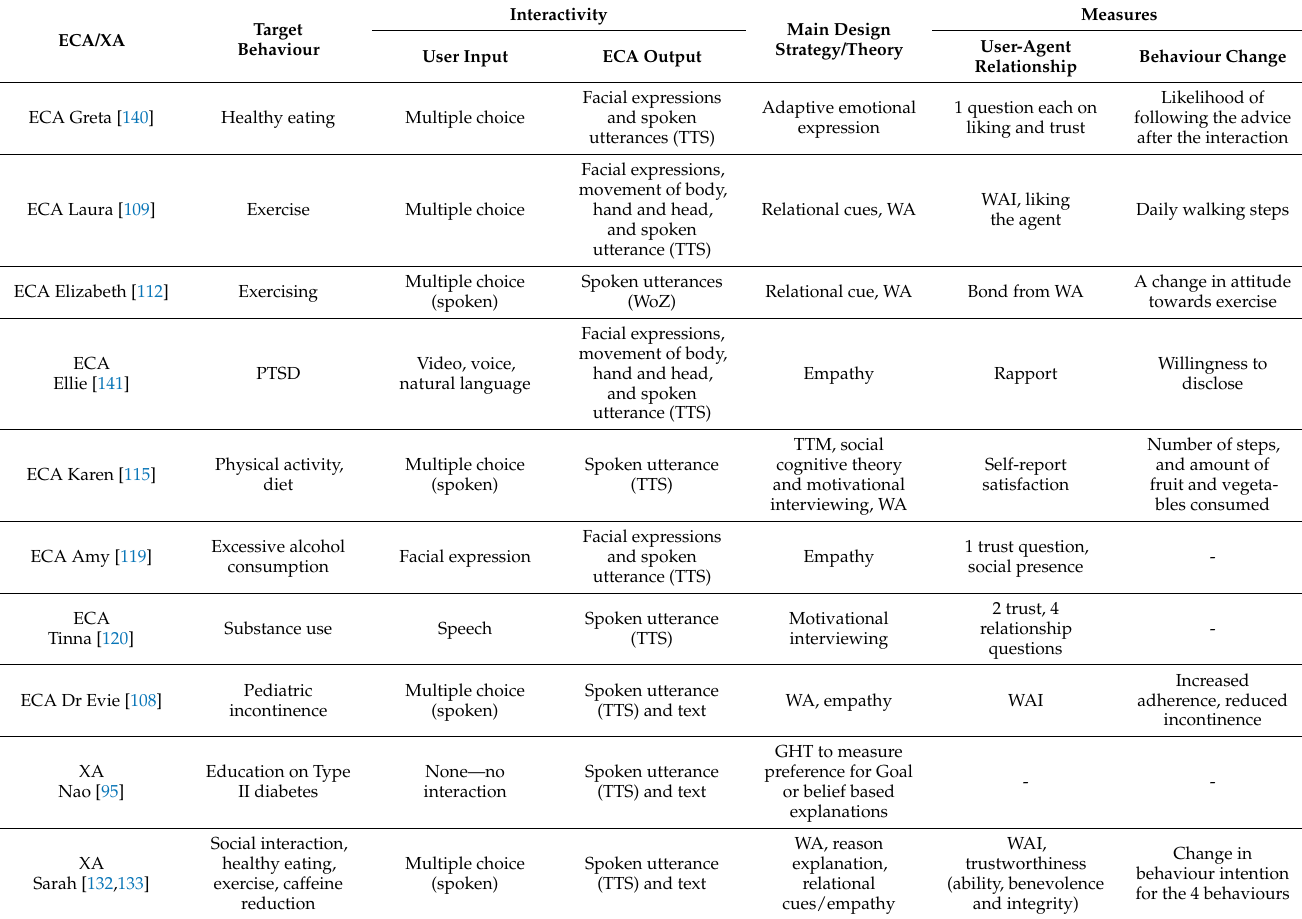
Table 1. Comparison of ECA/XAs for Behaviour